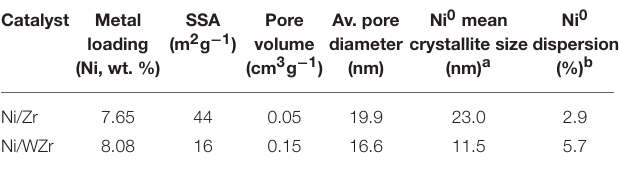
TABLE 2 | Physicochemical characterization results for the reduced Ni/Zr and Ni/WZr catalysts. Catalyst Metal